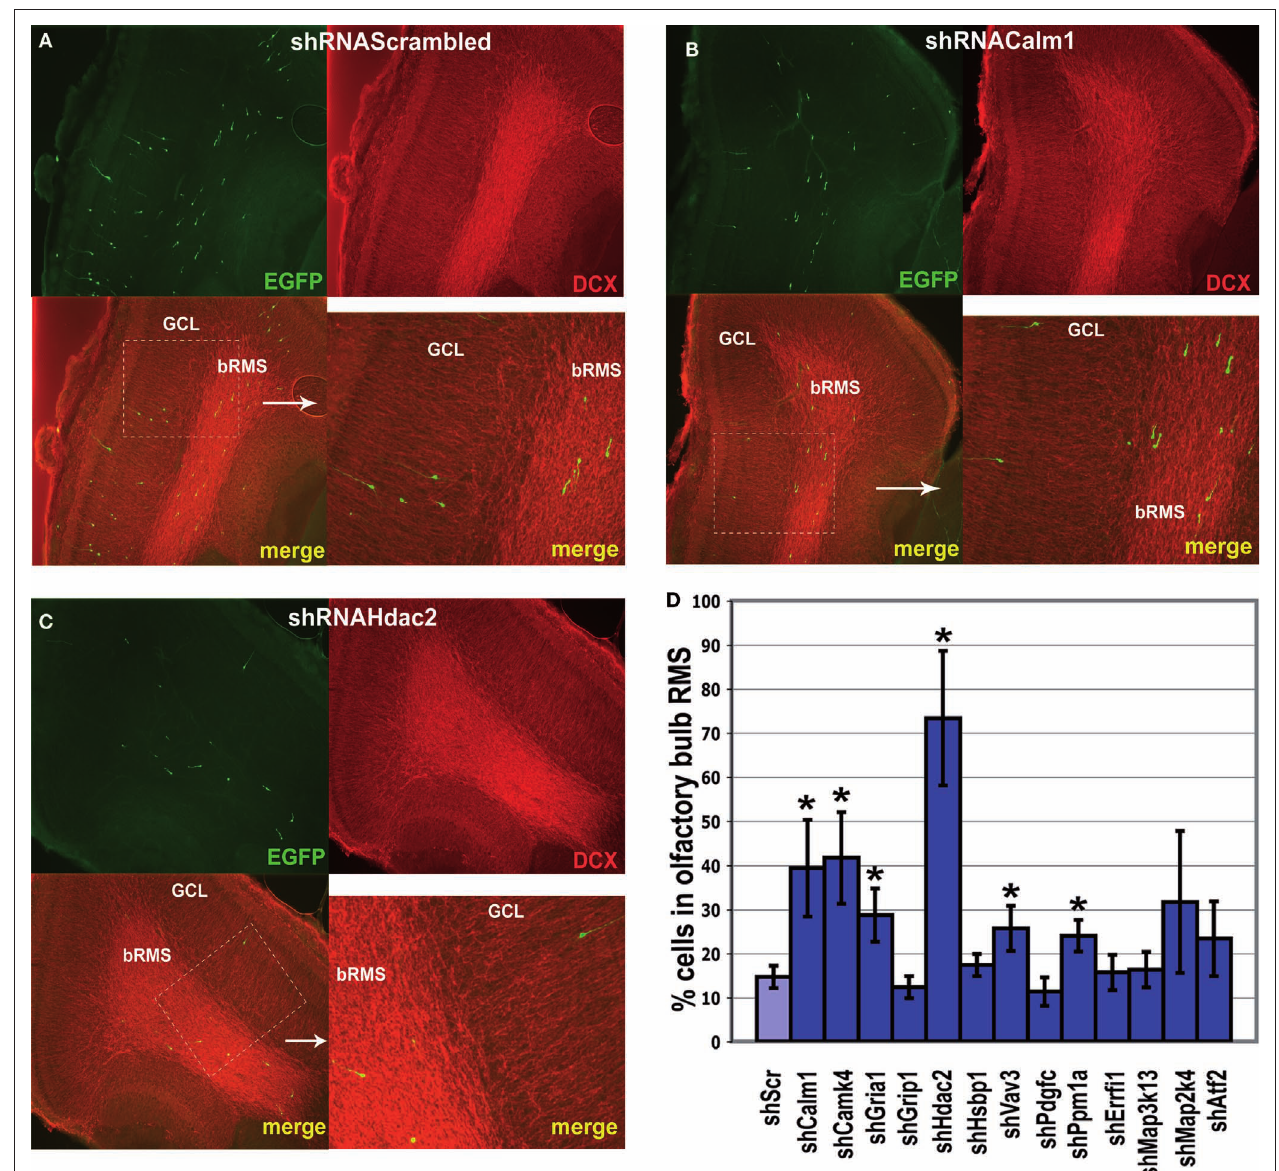
FIGURE 7 | Effect of in vivo gene expression knockdown on neuroblast migration in the olfactory bulb. The RMS within the olfactory bulb (bRMS) is visible as more intensely stained in the panels showing doublecortin (DCX) expression thus clearly delineating it from the more lightly stained granule cell layer (GCL). In comparison to control shRNAScrambled (A) , Calm1 (B) or